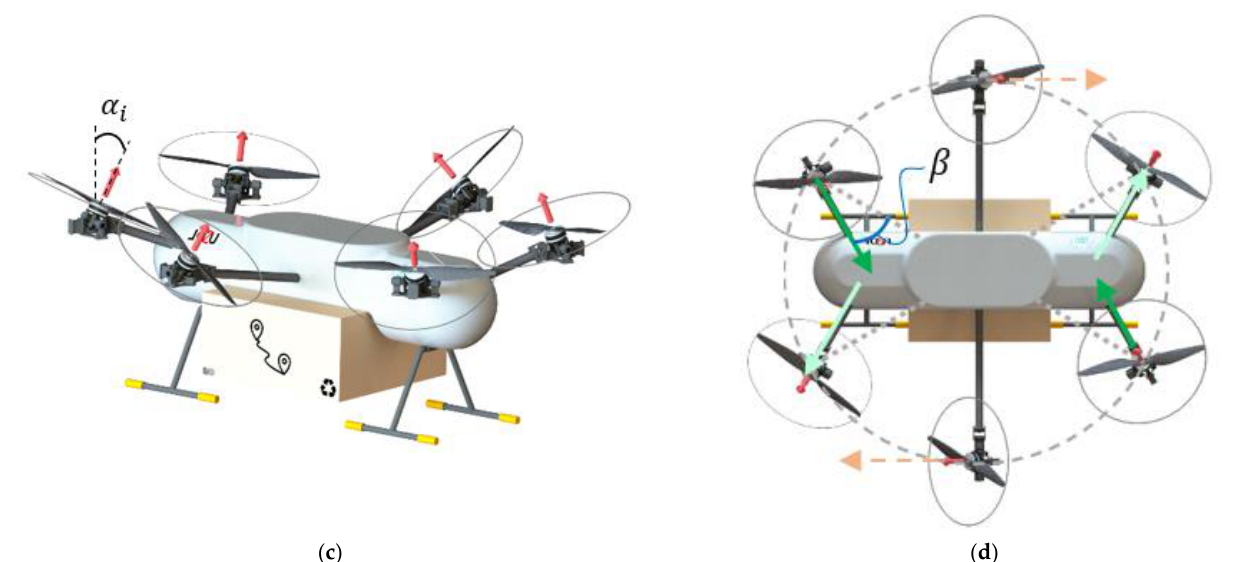
Figure 8. Comparison of proposed UAV preliminary design and UAV with tilting mechanism ( a ) preliminary design where all propellers tilting angles are zero (coplanar) ( b ) preliminary design with axis offsetting angle zero ( c ) 𝛼 𝑖 tilted propeller configuration ( d ) configuration with axis offset angle 𝛽 .